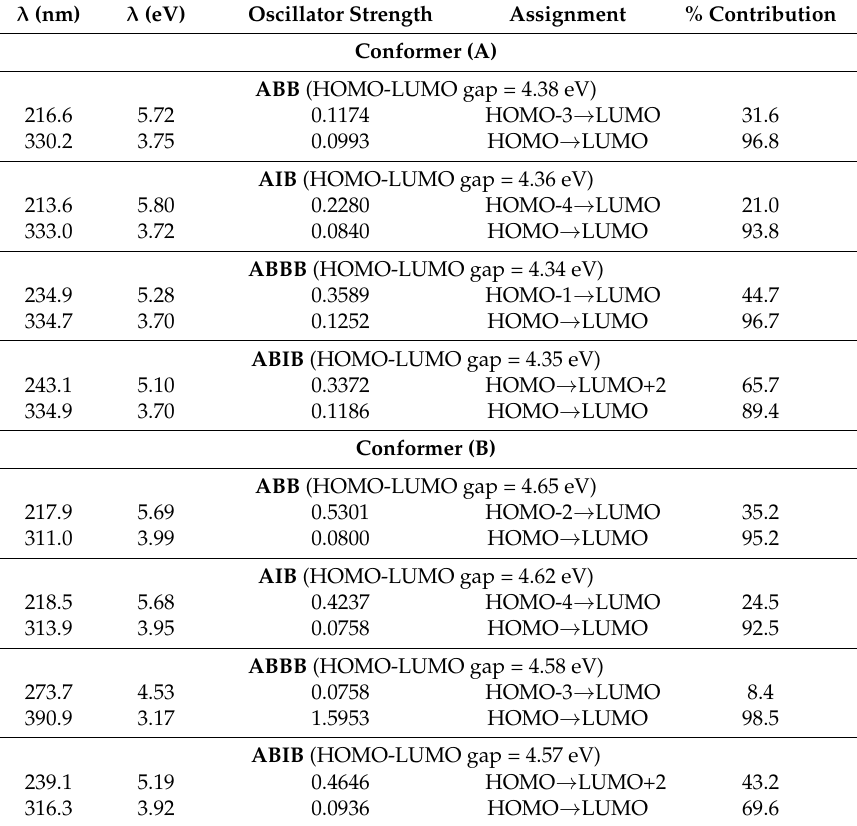
Table 3. Calculated electronic parameters of the two conformers of 2-aminobenzamides in